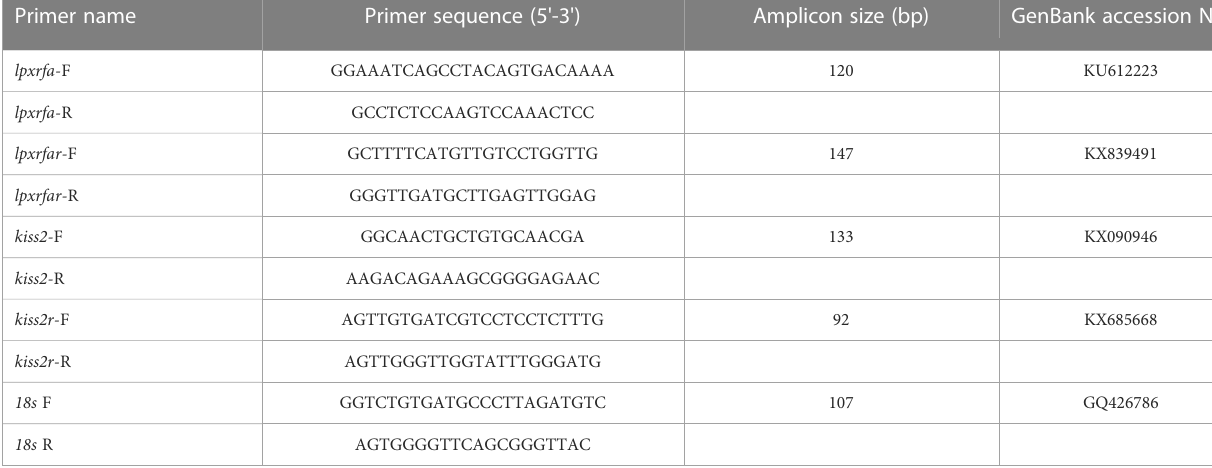
TABLE 1 List of primers used in this